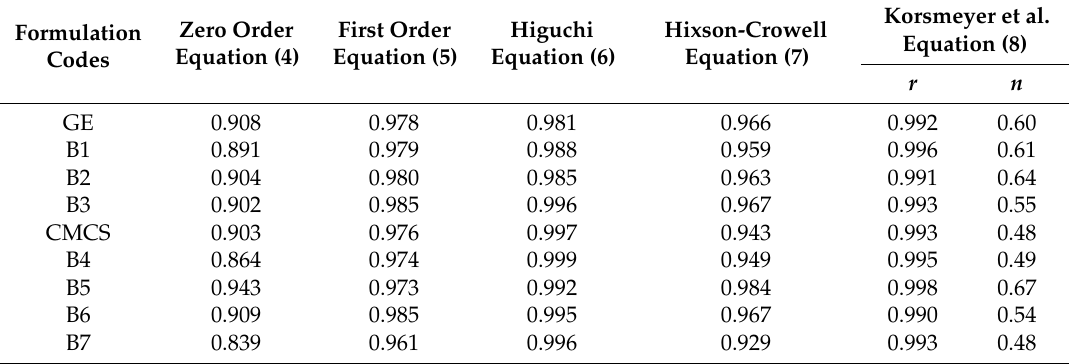
Table 2. Correlation coefficient ( r ) values of all the formulations estimated from different empirical equations.